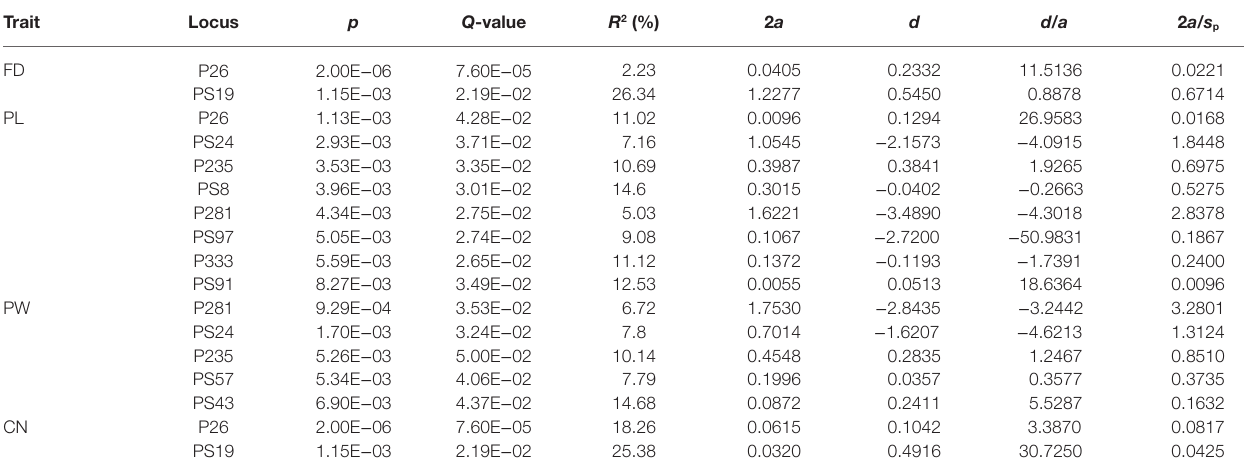
TABLE 4 | Significant SSR marker-trait pairs from the association test results of flower traits. Trait Locus p Q -value R 2 (%) 2 a d d / a